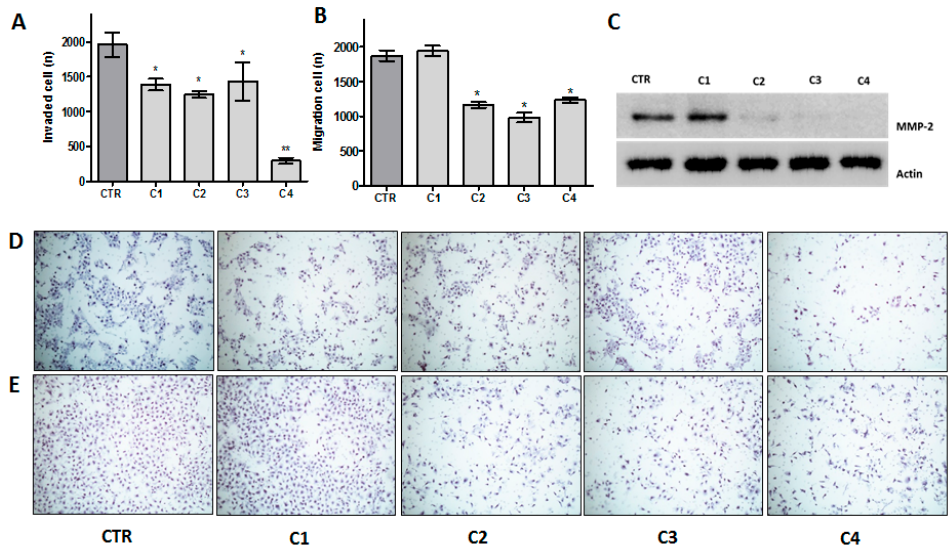
Figure 3. Effect of crude extract (C3) and fractions (C1, C2 and C4) of T. guianensis on HN13 cellular migration and invasion. ( A ) Invasion was measured at 24 h by Matrigel invasion assay, the results were expressed in relation to the DMSO control (considered as 100% of invasion) as the mean percentage of invasion ± SD; ( B ) analysis of index cell migration measured at 24 h by trans-well, the results are expressed as the means ± SD; ( C ) western blot analysis using the antibodies of anti-human MMP-2. The cells lines were incubated with compounds for 24 h; ( D , E ) representative images (at × 40 magnification) of migration and invasion assays, respectively. * p < 0.05; ** p < 0.01.